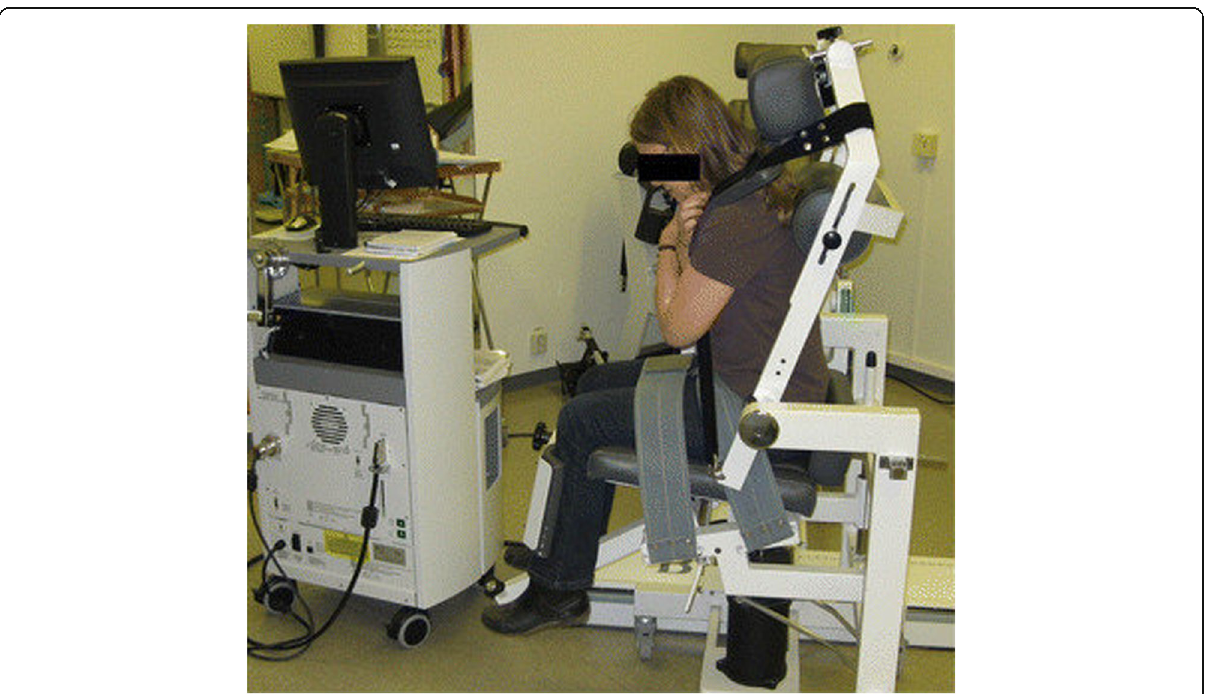
Fig. 1 The position of the participants on the back extension-flexion attachment of the isokinetic dynamometer with the trunk upright, hips and knees flexed at 90°, and thighs parallel to the